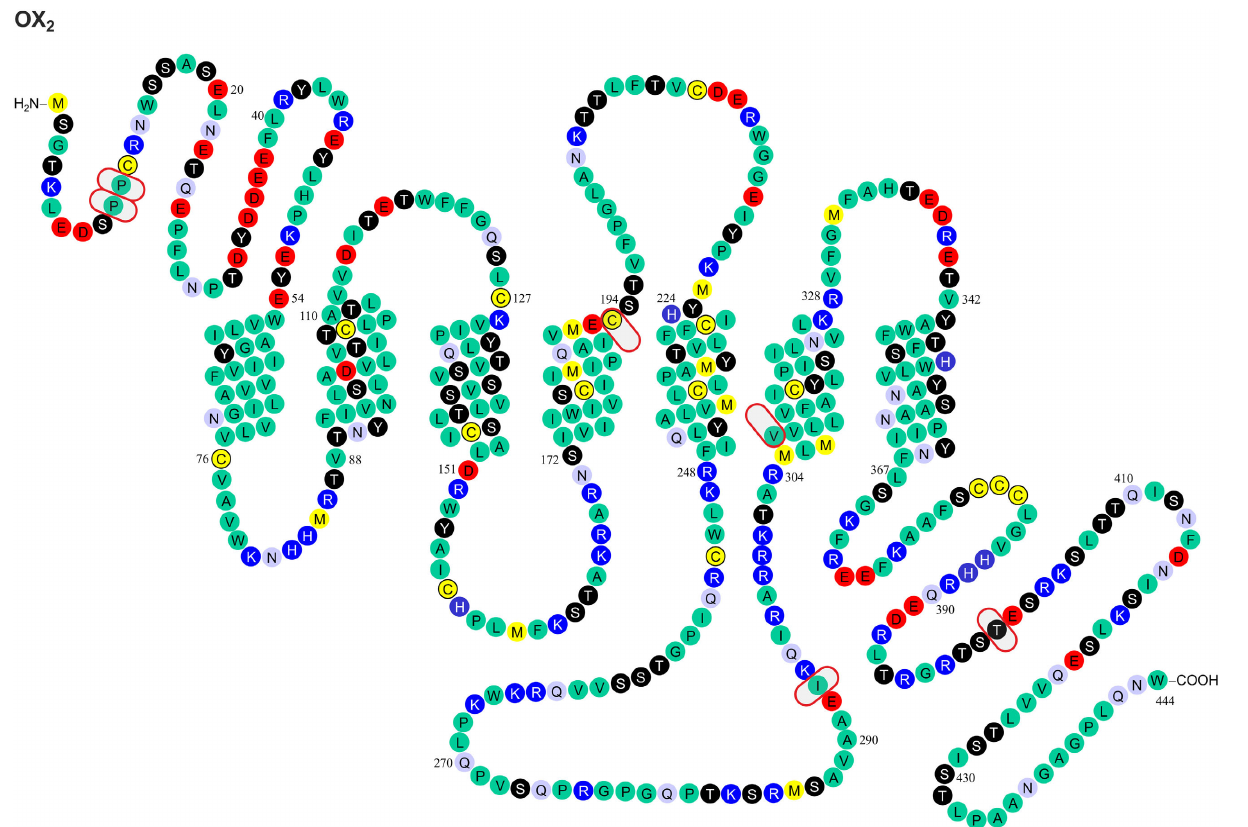
FIGURE 2 | Known amino acid sequence-changing variants of human OX 2 receptor. The variants are OX 210 Pro/Ser, OX 211 Pro/Thr, OX 2193 Cys/Ser, OX 2293 Ile/Val, OX 2308 Val/Ile, and OX 2401 Thr/Ile. The findings originate from Peyron et al. (2000) and Olafsdottir et al. (2001).